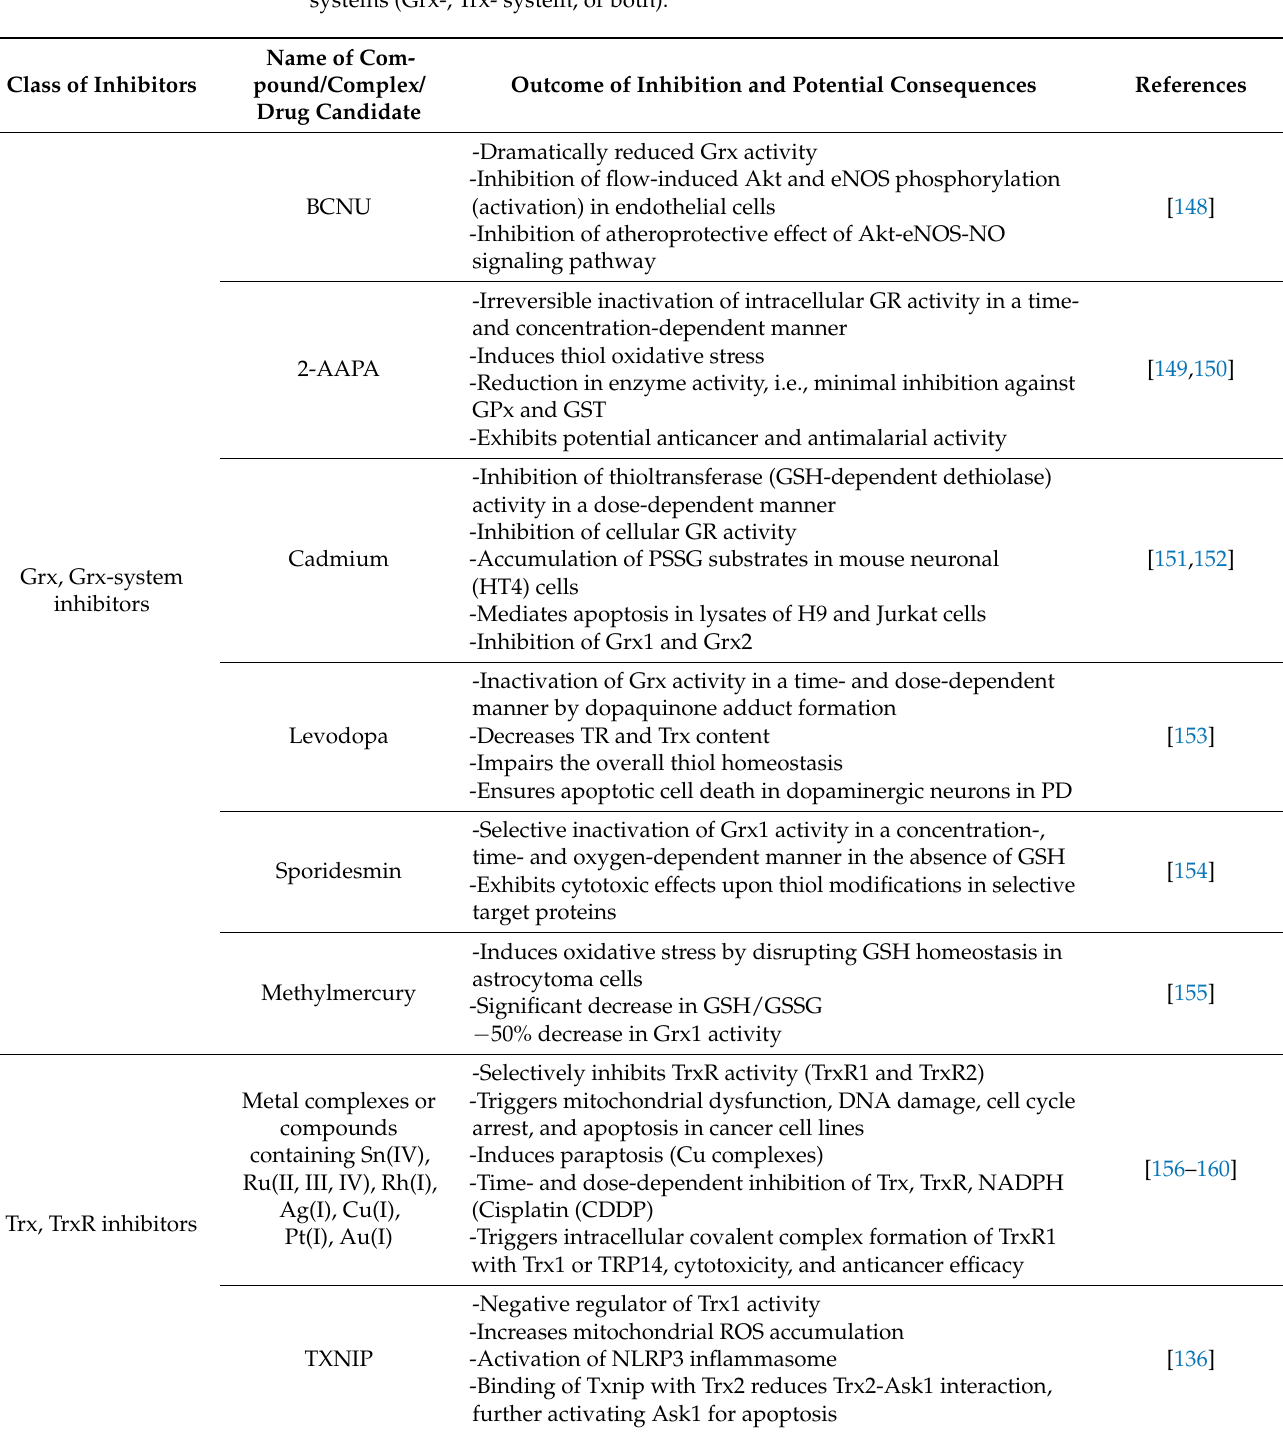
Table 2. This table highlights some of the well-established synthetic as well as natural inhibitors and further analyses their inhibitory potency based on their selective inhibition of the major redoxin systems (Grx-, Trx- system, or